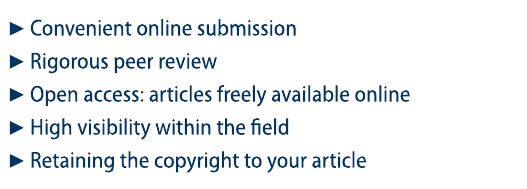
Figure 19: SEM (SE image) with numerous spherical phases and a centered barite crys- tal, sample 7.2 (PV07; 60 °C/20 bar). Instead of: SEM (SE image) of barite with